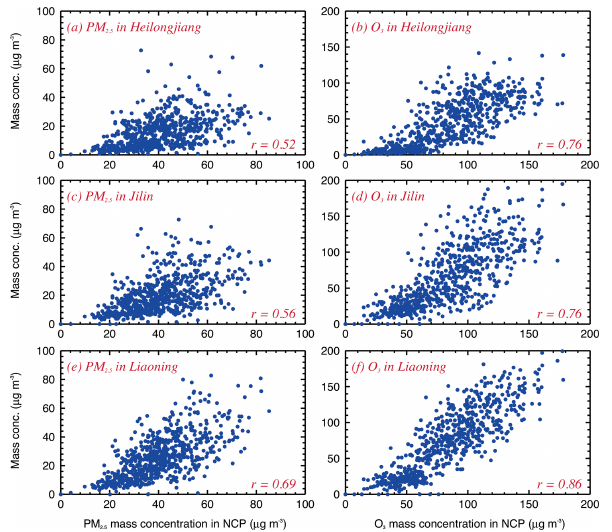
Figure 3. Relationships of observed PM 2 . 5 and O 3 concentrations in the NCP with those in NEC during May to September from 2013 to 2016.